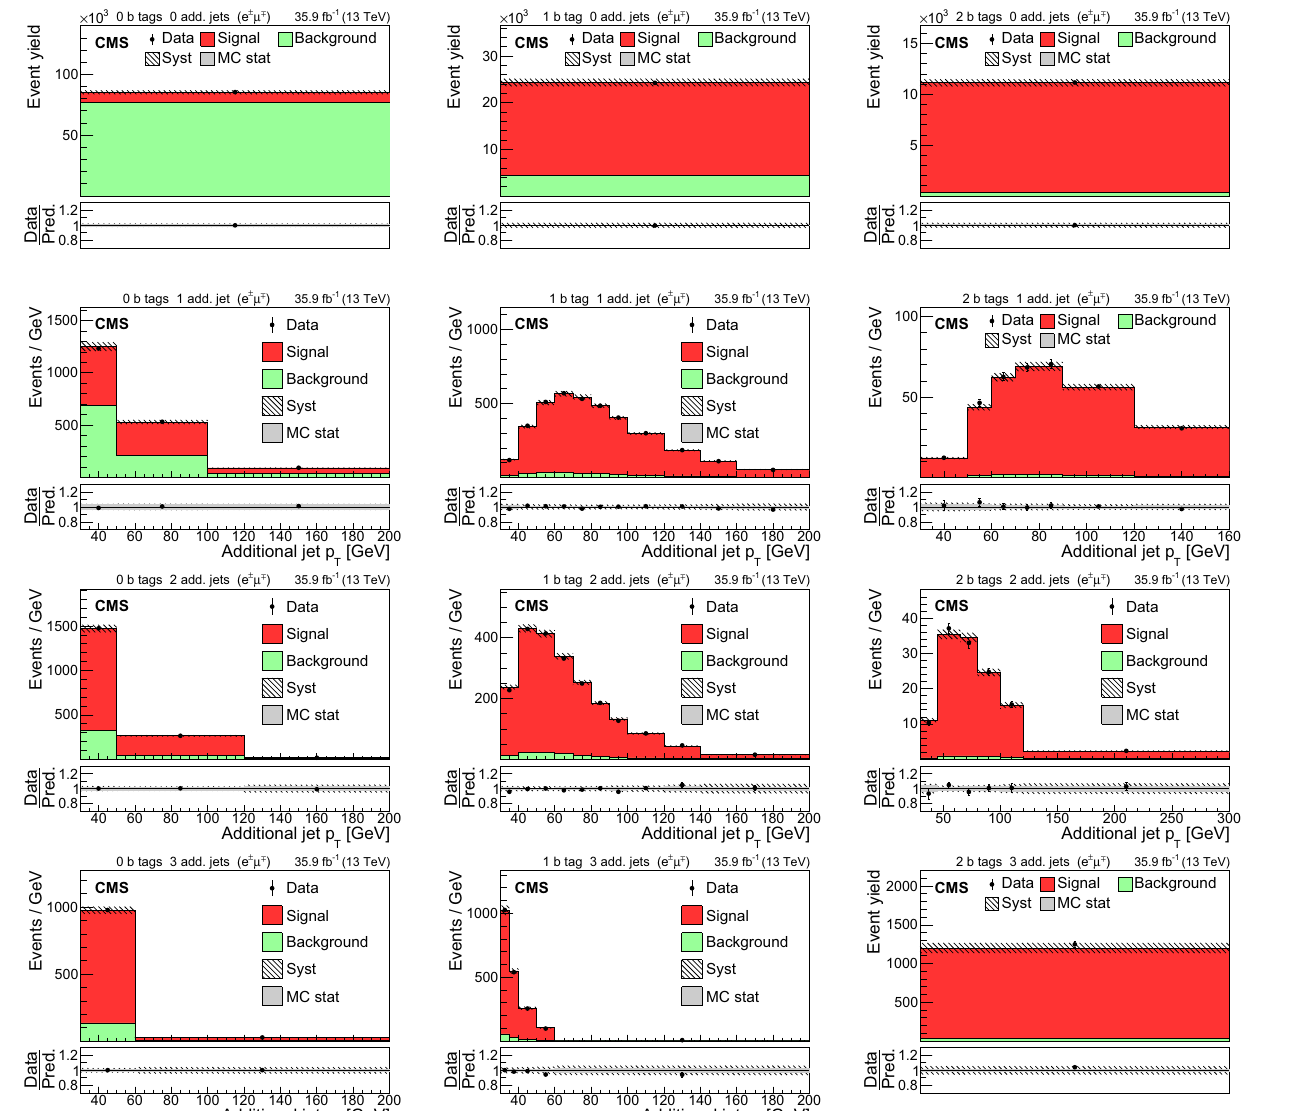
Fig. 4 Distributions in the e ± μ ∓ channel after the fit to the data. In the left column events with zero or three or more b-tagged jets are shown. The middle (right) column shows events with exactly one (two) b-tagged jets. Events with zero, one, two, or three or more additional non-b-tagged jets are shown in the first, second, third, and fourth row,